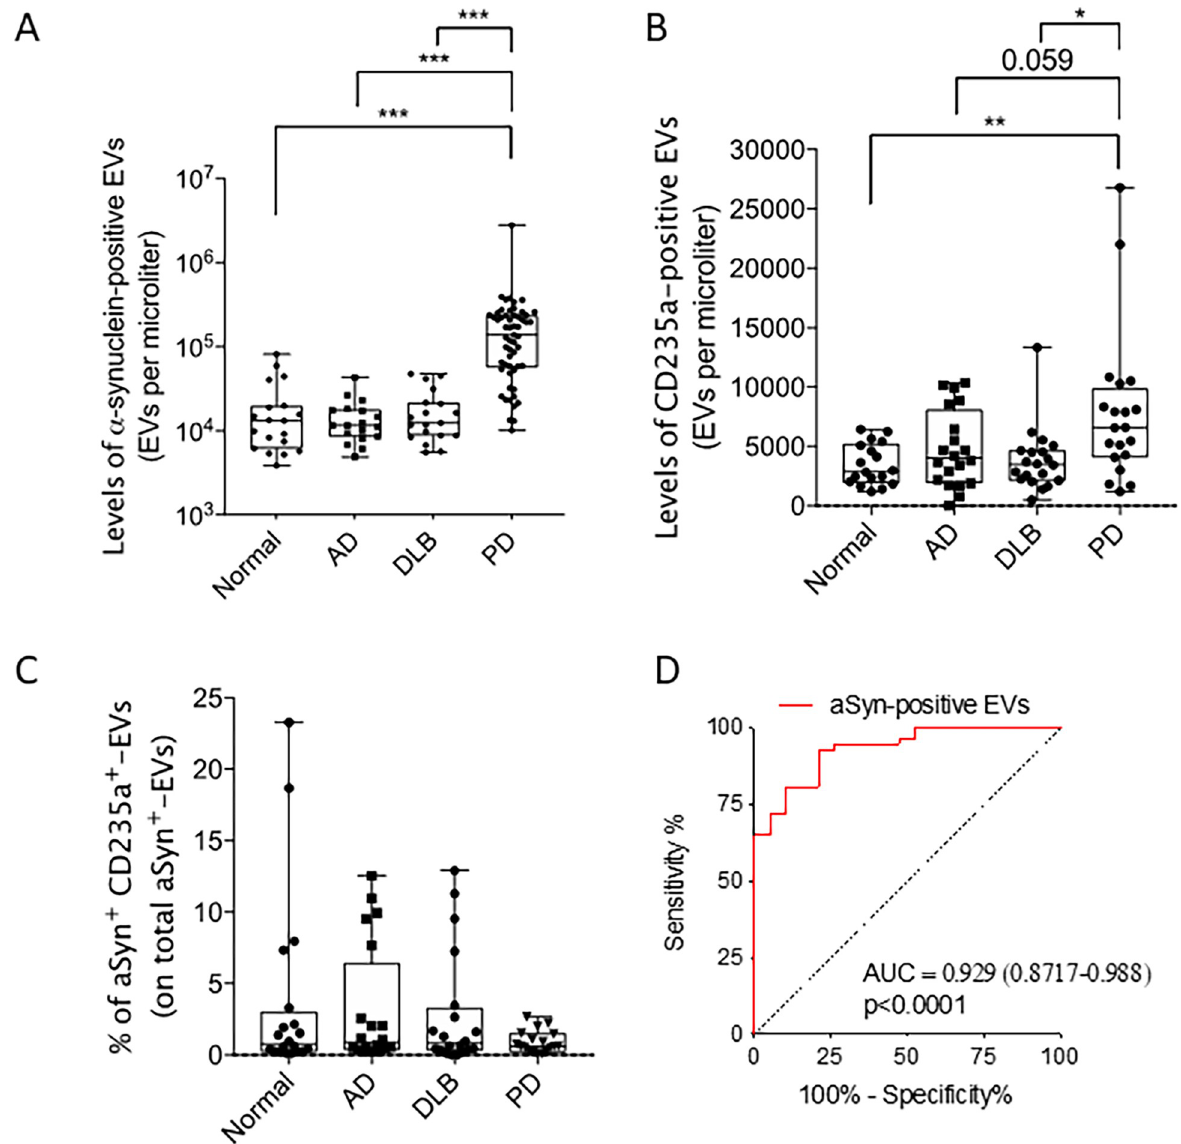
Fig 1. Levels of α -synuclein extracellular vesicles distinguish Parkinson disease (PD) patients from age-matched healthy individuals, Alzheimer disease (AD) patients, and patients having dementia with Lewy bodies (DLB). Comparison between levels of a-syn EVs in normal, AD, DLB, and PD patients. A) Levels of a-syn positive EVs in the four groups; B) Levels of CD32 a-syn EVs in the four groups C) Percentage of CD32 a-syn in the four groups; D) Receiving Operator Curve of identifying a-syn positive EVs compared to controls: sensitivity of 92.98% and a specificity of 78.95% at a cut-off of 20,700 α -synuclein-EVs per microliter of blood. ��� indicates the first batch of samples where CD235a was